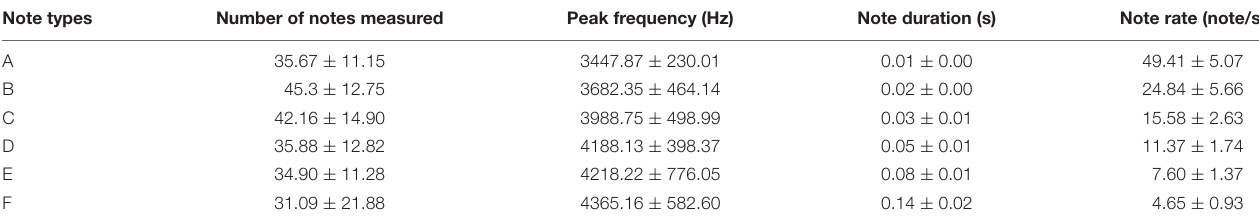
TABLE 1 | Descriptive statistics of alarm calls parameters in A. orientalis .